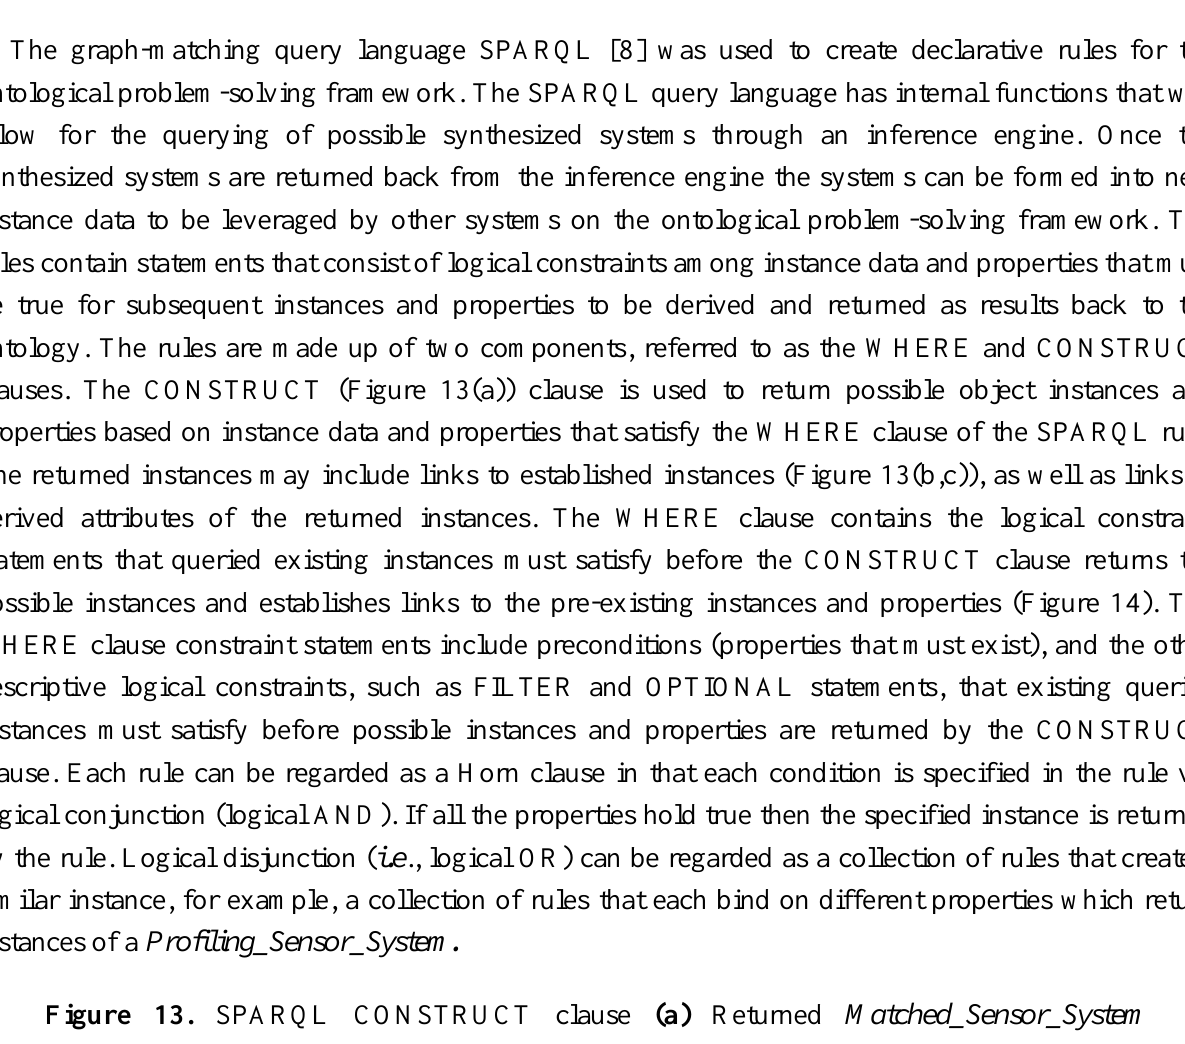
Figure 13. SPARQL CONSTRUCT clause (a) Returned